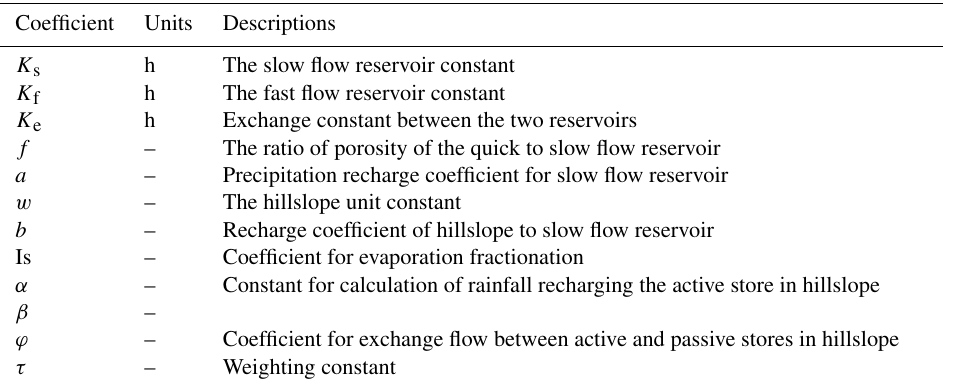
Table A2. Description of the calibrated parameters. Coefficient